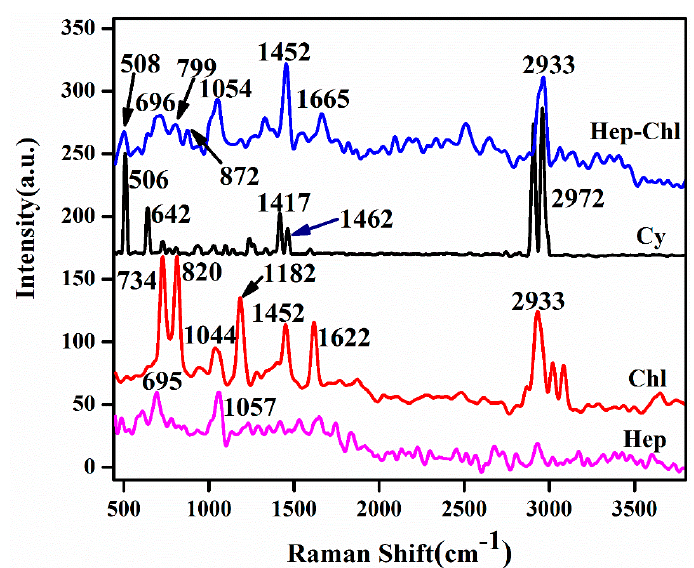
Figure 2. Raman spectra of heparin (Hep), chlorambucil (Chl), cystamine dihydrochloride (Cy), and the conjugate Hep–Cy–Chl.